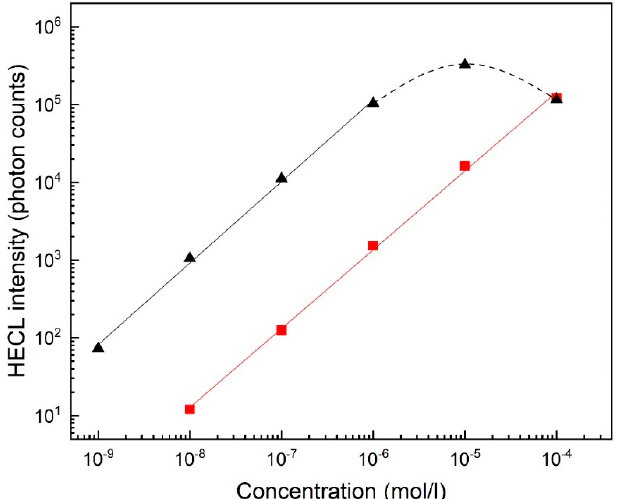
Figure 6. Calibration curves for fluorescein isothiocyanate (FITC) with 0.01 M NaN 3 in 0.05 M Na 2 B 4 O 7 , 0.1 M Na 2 SO 4 . RS electrode. EC-CB (triangles), PS-CB (squares). Conditions: 500